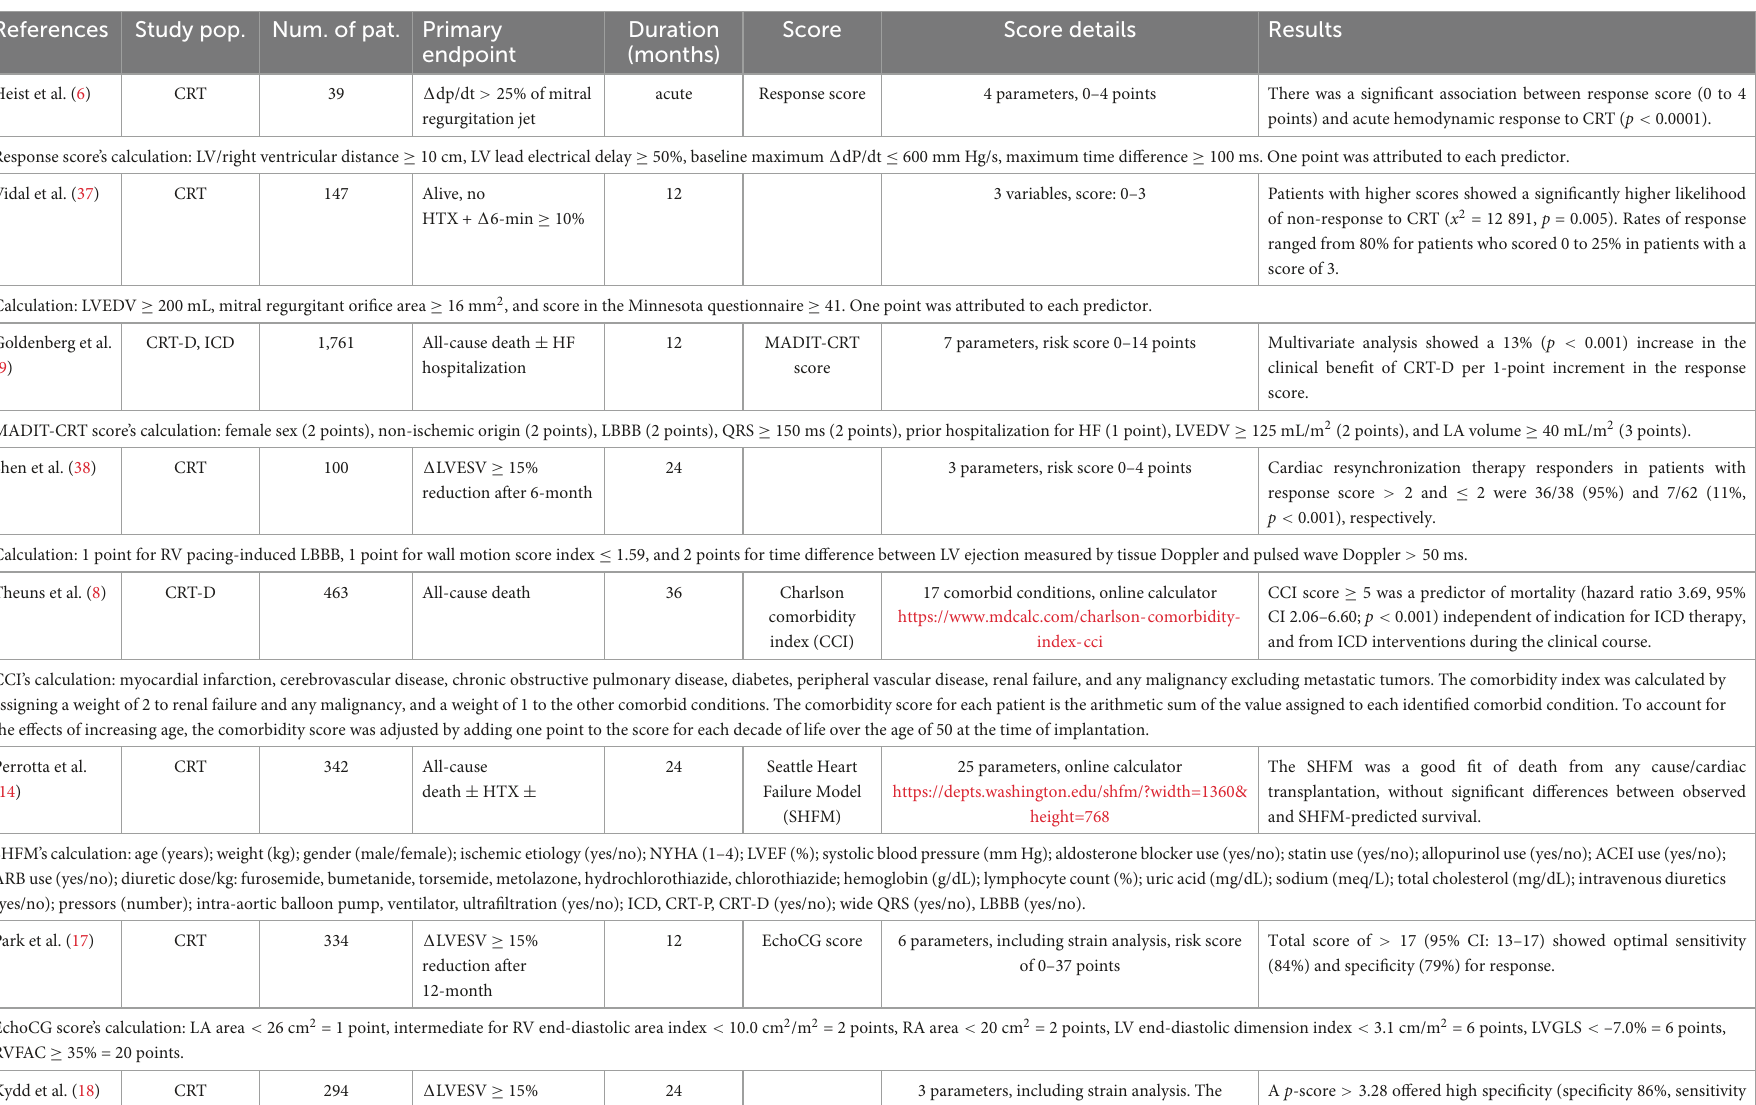
TABLE 1 Risk scores in cardiac resynchronization